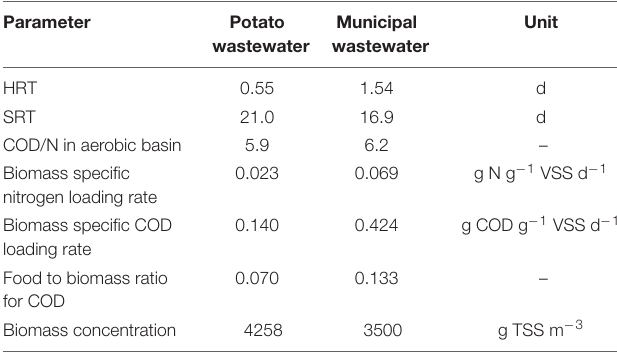
TABLE 6 | Indicative process variables for the two considered